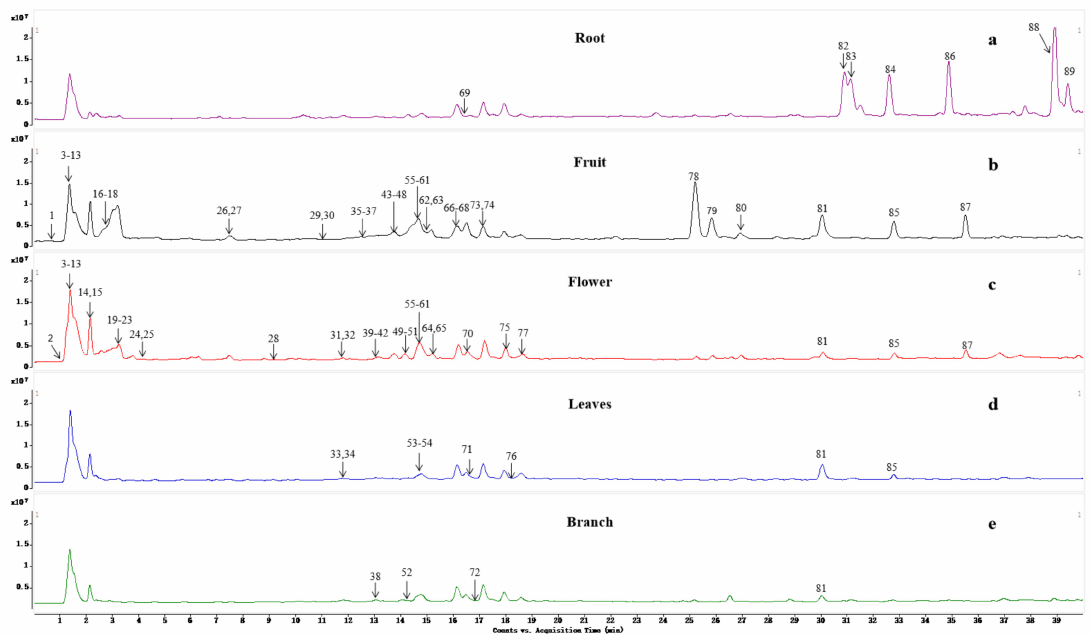
Figure 3. The total ion chromatogram (TIC) of root ( a ), fruit ( b ), flower ( c ), leaves ( d ), and branch ( e ) of Citrus aurantium L. var. amara